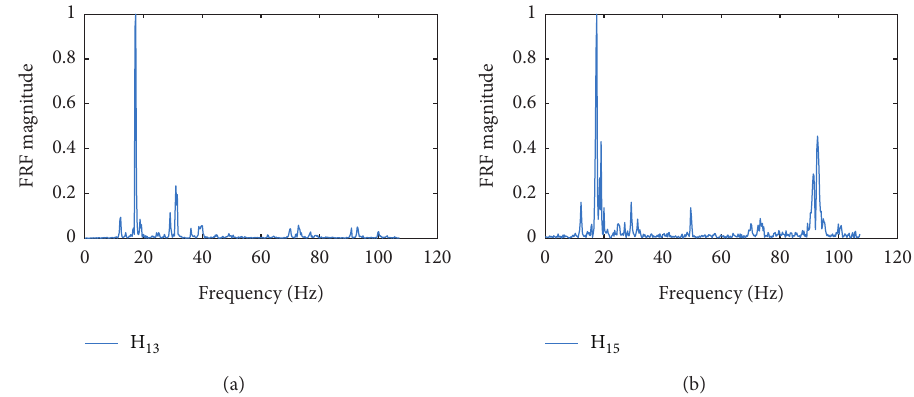
Figure 11: (a) FRF of the measured acceleration at the base (A1) for the undamaged case with (a) impact at A3 and (b) impact at